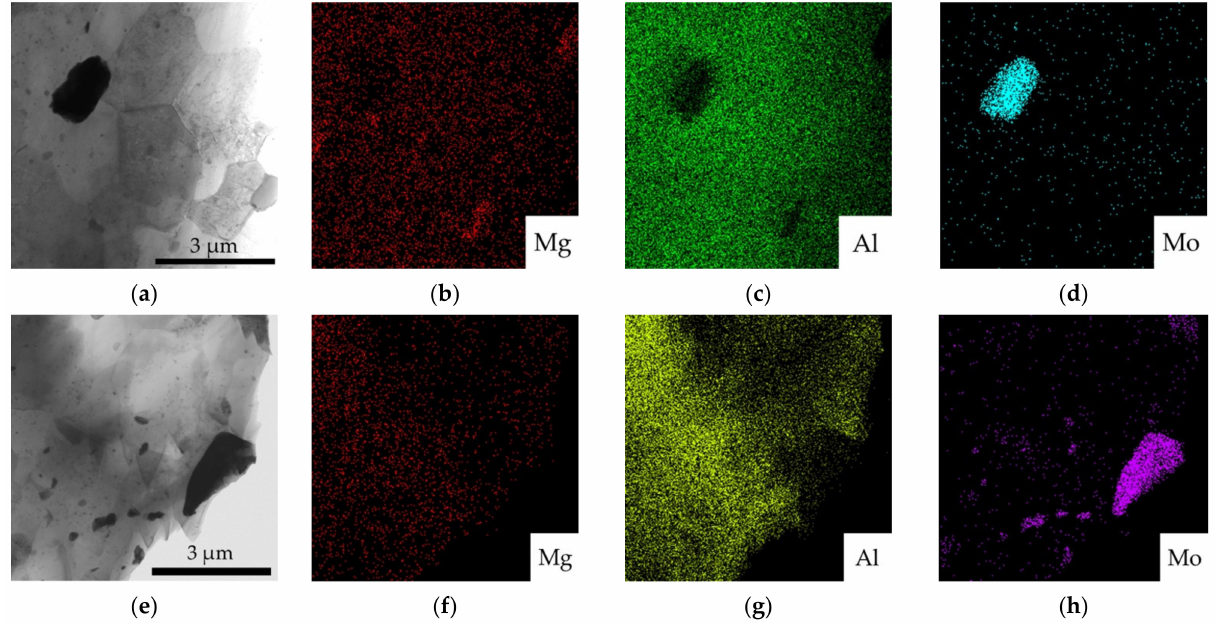
Figure 9. Light-field TEM images of the stir zone and chemical element distribution maps of samples 15.1 ( a – d ) and 15.4 ( e – h